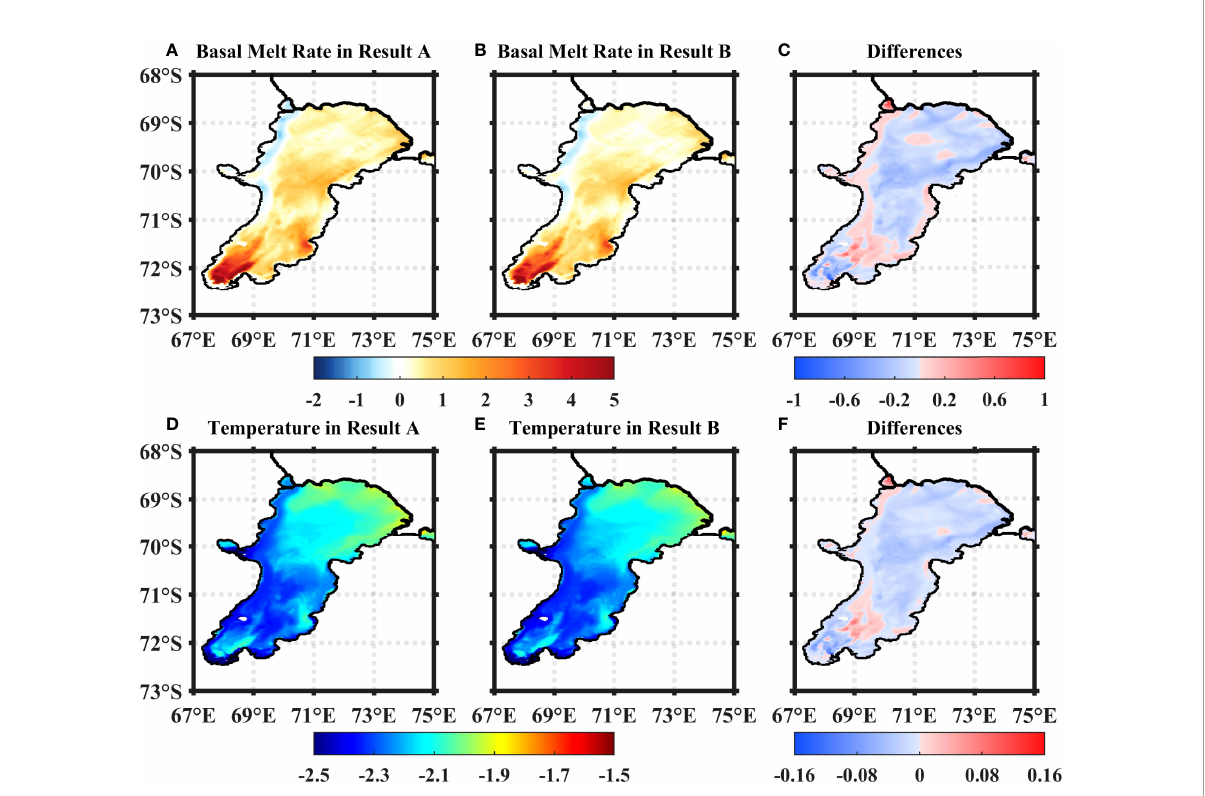
FIGURE 8 The basal melt rate (m yr -1 , melting is positive) of the AIS in (A) Result A and (B) Result B. The solid black lines are the coastline, the grounding line, and the AIS calving front. (C) The differences between Result A and Result B (A, B) . (D – F) Same as (A – C) , but for the potential temperature (°C) of the layer adjacent to the AIS basal